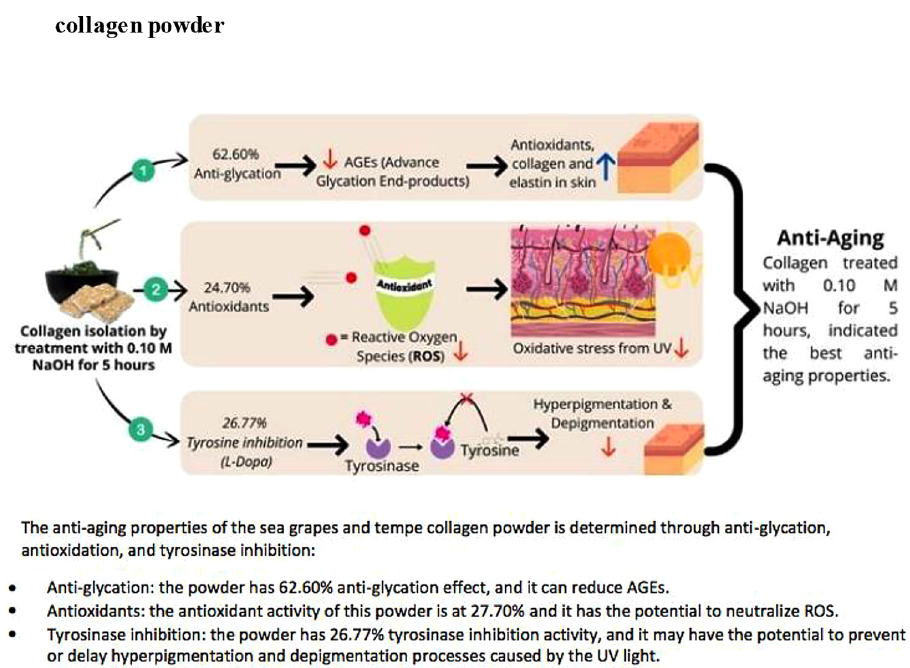
Figure 2. Anti-glycation, antioxidant, and tyrosinase inhibition of sea grapes and tempe collagen